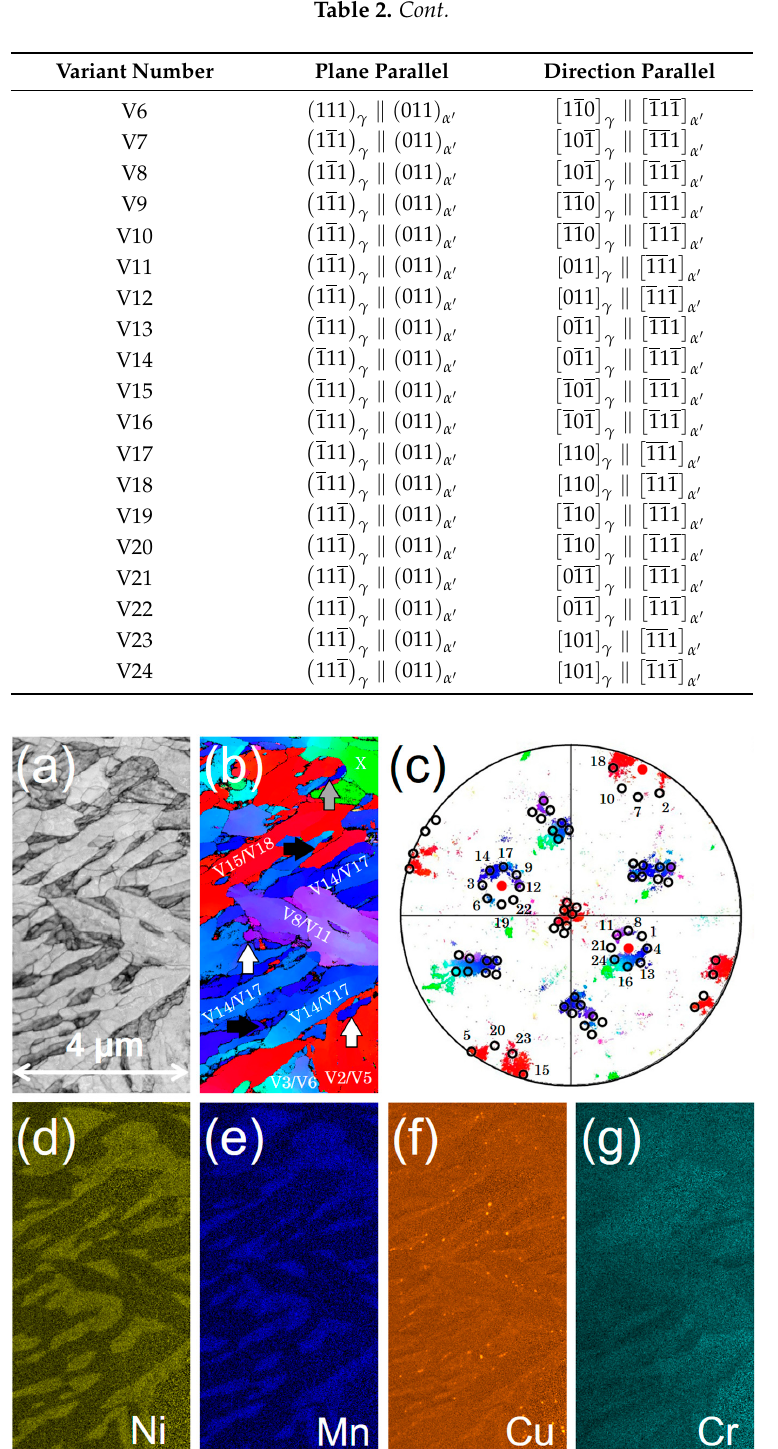
Figure 8. TKD mapping showing ( a ) band contrast, ( b ) inverse pole figure—Z, ( c ) experimental and simulated pole figures, ( d ) Ni distribution, ( e ) Mn distribution, ( f ) Cu distribution, and ( g ) Cr distribution in NiCu steel after tempering at 720 °C.